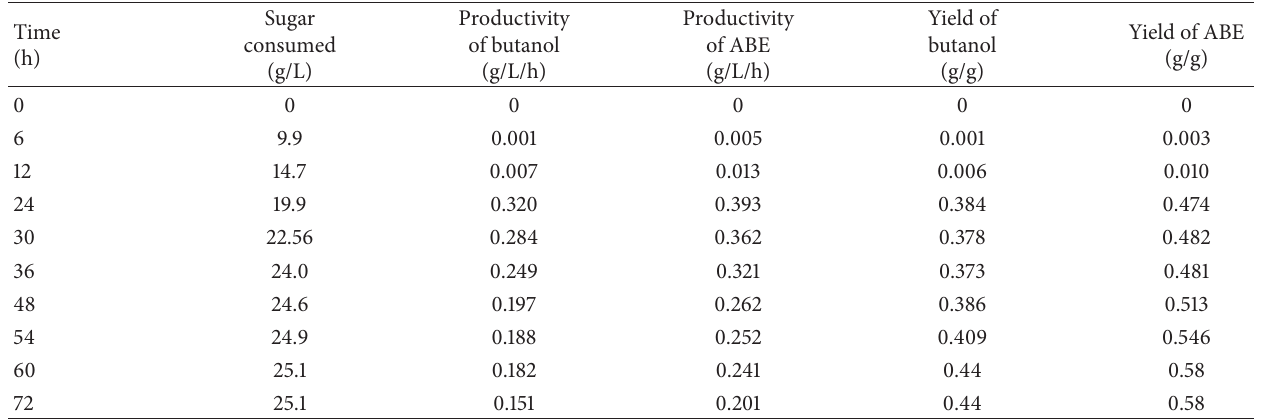
Table 4: ABE fermentation by C. acetobutylicum NCIMB 13357 using 50 g/L date fruit in P2 medium. Time